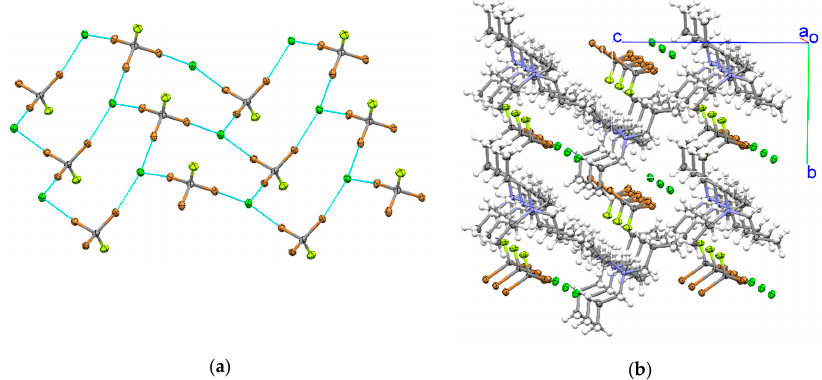
Figure 1. ( a ) 2D network formed by tribromofluoromethane and Cl − anions in (Pr 4 N)Cl · CBr 3 F co- crystals 1. (Note: blue lines show halogen bonds.) ( b ) Crystal lattice in the co-crystals.